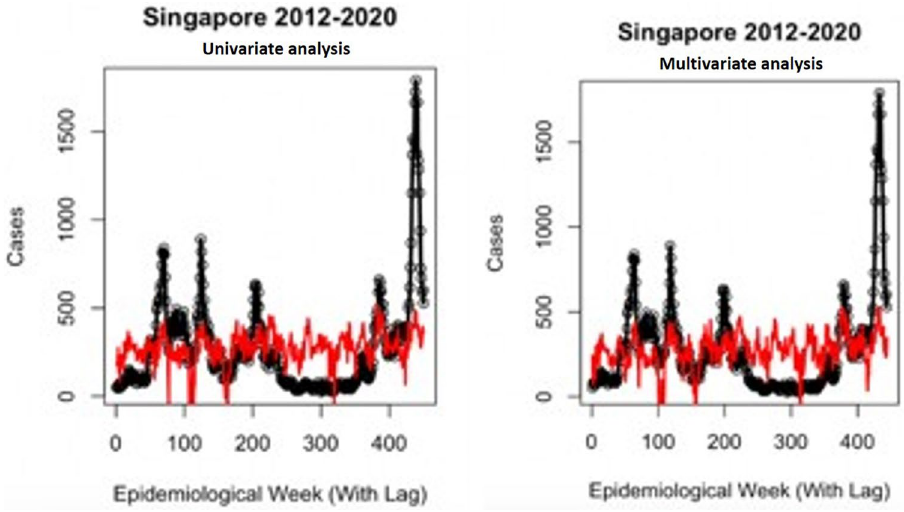
Figure 4. Graph showing Singapore univariate and multivariate climate regressions. Singapore univariate model utilizes dew point, while multivariate model additionally adjusts for wind speed and maximum temperature. Colored line indicates prediction and the scatter plot indicates the reported cases.